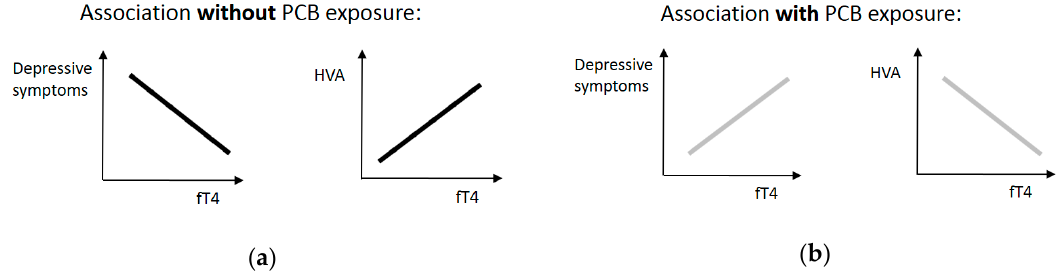
Figure 1. Schematic illustration of the postulated interaction hypotheses. Note: PCB = polychlorinated biphenyls, HVA = homovanillic acid, fT4 = free thyroxin.